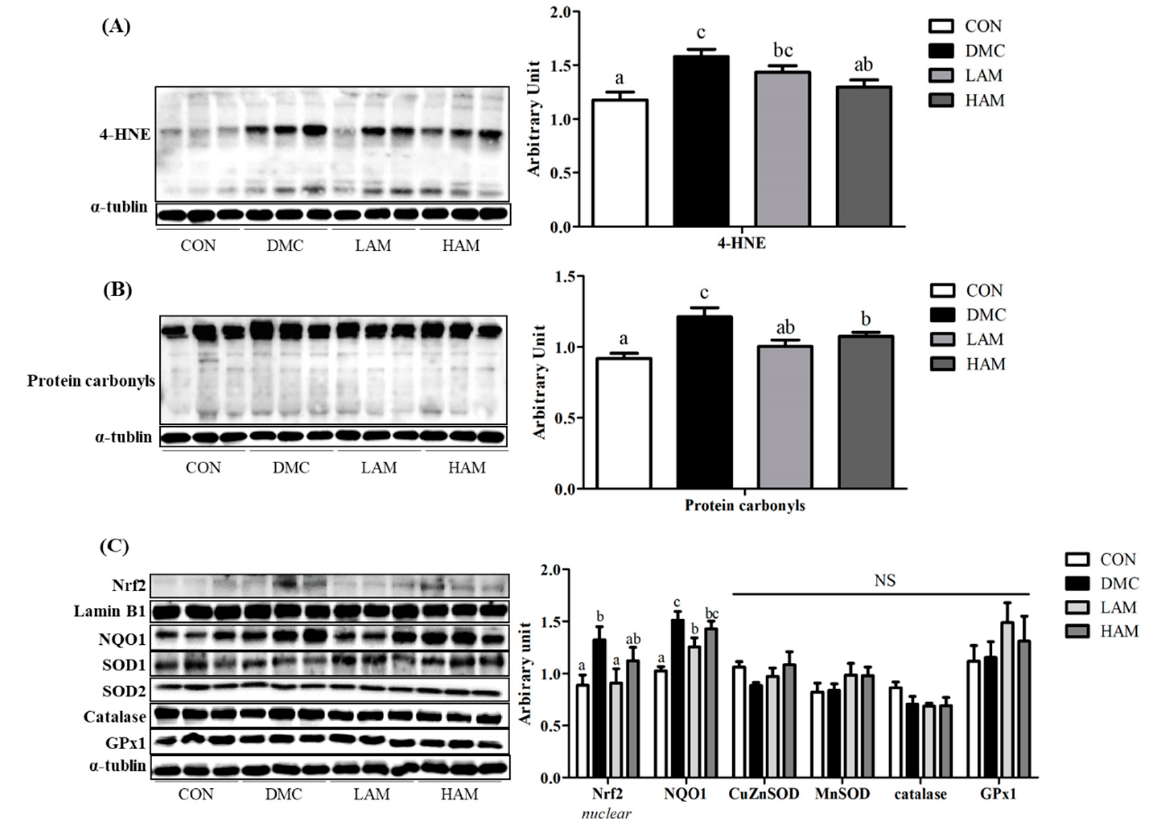
Figure 7. Effect of AME on ( A ) 4-HNE, ( B ) protein carbonyls, and ( C ) oxidative stress related markers in T2DM mice All values are reported as mean and SEM. Values with the different superscript letter were significantly different ( p < 0.05; ANOVA with post-hoc Duncan’s multiple range test). n = 6 mice in each group CON, normal control group (negative control); DMC, type 2 diabetic control group (positive control); LAM, diabetic group supplemented with low dosage (50 mg/kg BW) of AME; HAM, diabetic group supplemented with high dosage (100 mg/kg BW) of AME.